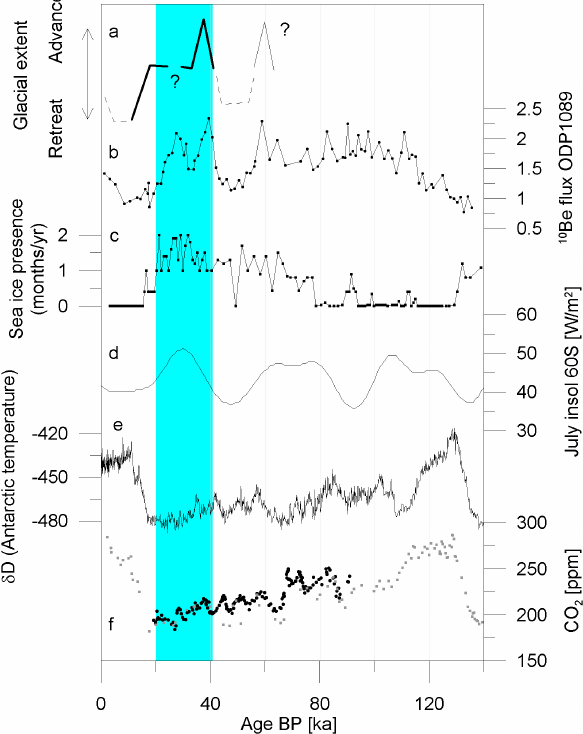
Fig. 3. Comparison of the glacial chronology in the southern Cen- tral Andes in the paleoclimatic context. (a) Glacial extents, indi- cating the northward shift of the westerlies, (b) changes in the cos- mic ray flux (transport corrected 10 Be flux [at cm − 2 kyr − 1 ] × 10 9 ) (Christl et al., 2007), (c) sea ice duration around Antarctica (Crosta et al., 2004), (d) austral winter insolation at 60 ◦ S, (e) deuterium from the Vostok ice core as proxy for Antarctic temperatures (Pe- tit et al., 1999), and (f) atmospheric CO 2 concentrations (Ahn and Brook, 2008; Petit et al.,